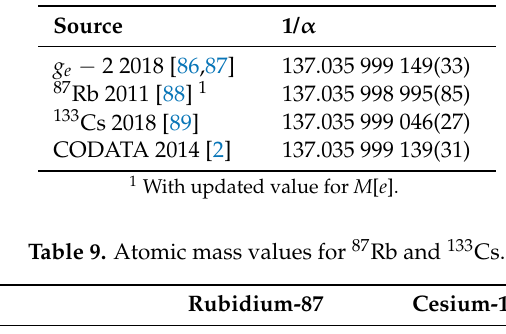
Table 8. Recent results for the inverse fine-structure constant.